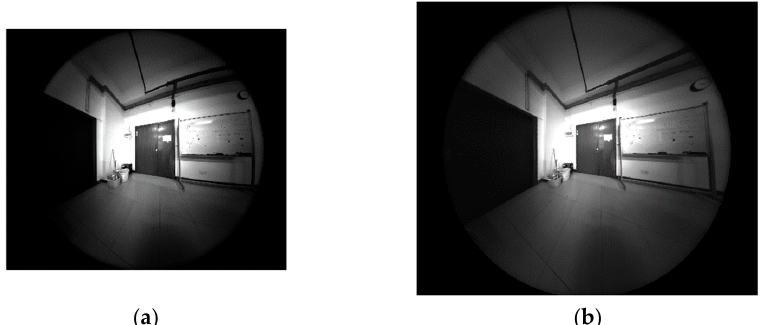
Figure 18. Experimental results of the indoor scene. ( a ) Distorted image of size 2048 × 2448 pixels; ( b ) Corrected image of size 2496 × 2984 pixels.